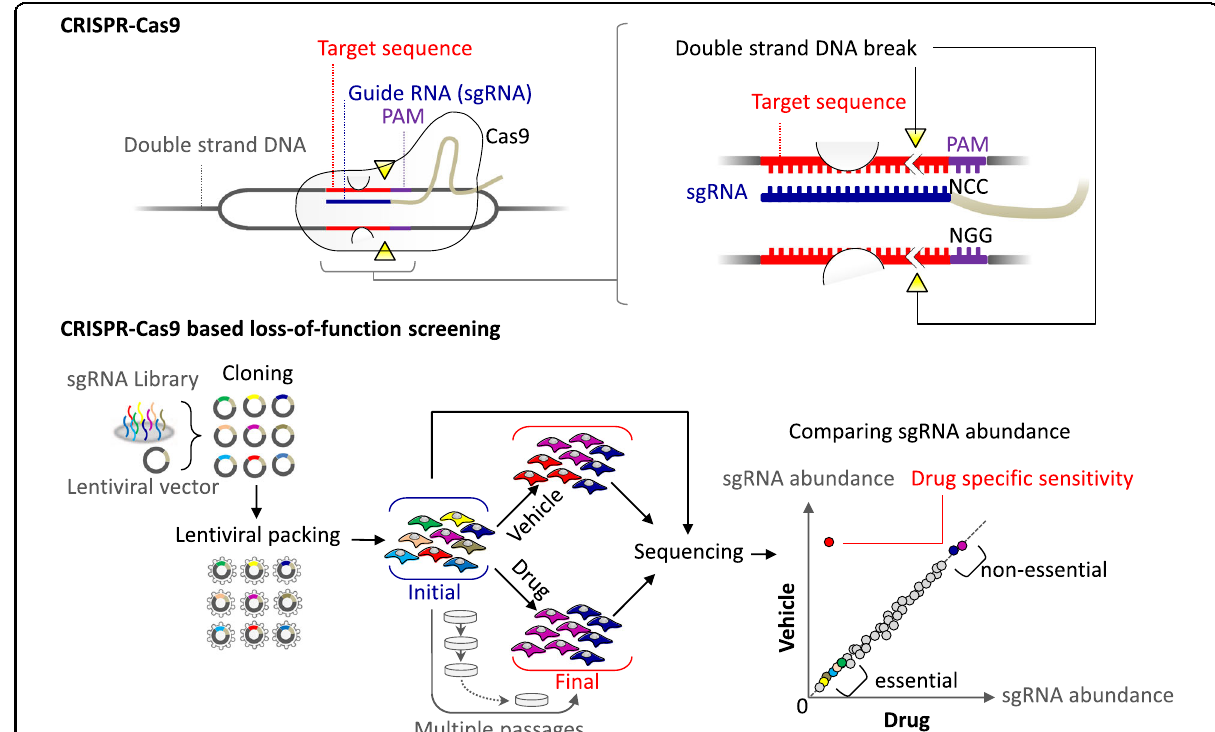
Fig. 4 CRISPR/Cas9-based screening for the study of metabolism. (CRISPR – Cas9) The CRISPR/Cas9 system induces DNA double strand breaks at target genes of interest, thereby inducing gene knockouts. Cas9 speci fi city is derived from the complementarity of the single-guide RNA (sgRNA) sequence to the target gene of interest, as well as the requirement of the PAM sequence DNA binding and cleavage. (CRISPR/Cas9-based loss-of- function screening) The CRISPR/Cas9 system can be applied to whole genome loss-of-function screening to identify metabolic genes that are essential under de fi ned metabolic states. First, a library of sgRNAs targeting the whole human genome are cloned into a to lentiviral vector encoding Cas9, and followed by packaging into lentiviral particles. Following infection, cells are treated with vehicle or a metabolic inhibitor, serially passaged, and sequenced. By comparing the abundance of sgRNAs in the fi nal cell populations (both vehicle or inhibitor) to their initial representation, the selective depletion of sgRNAs in the inhibitor treated population can be determined. CRISPR clustered regularly interspaced short palindromic repeats, PAM protospacer adjacent motif, sgRNA single-guide